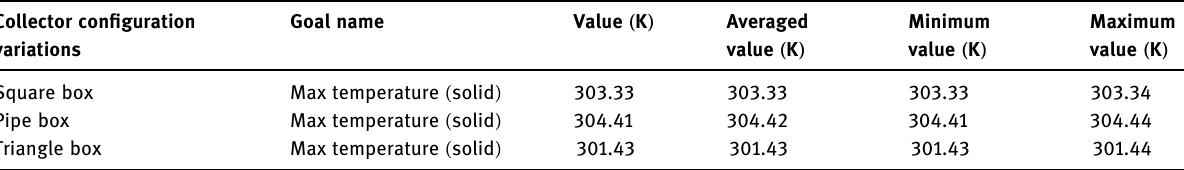
Table 5: Temperature simulation results from the thermal con fi guration of the collector Collector con fi guration